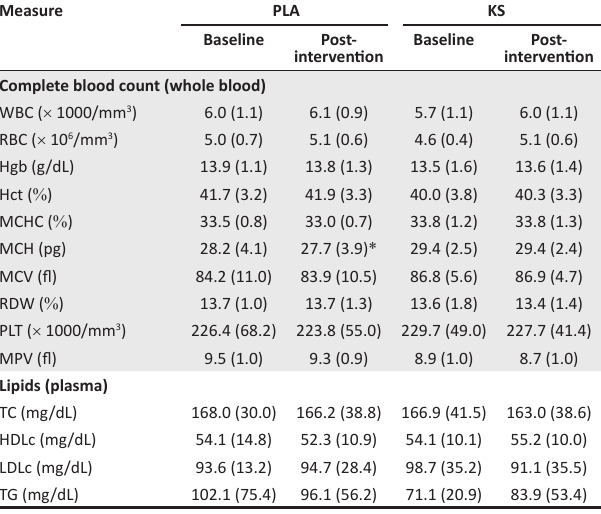
TABLE 3: Complete blood count and lipid panel before and after taking the placebo or ketone salt supplement for 6 weeks. Measure PLA KS Baseline Post- Baseline Post- intervention intervention